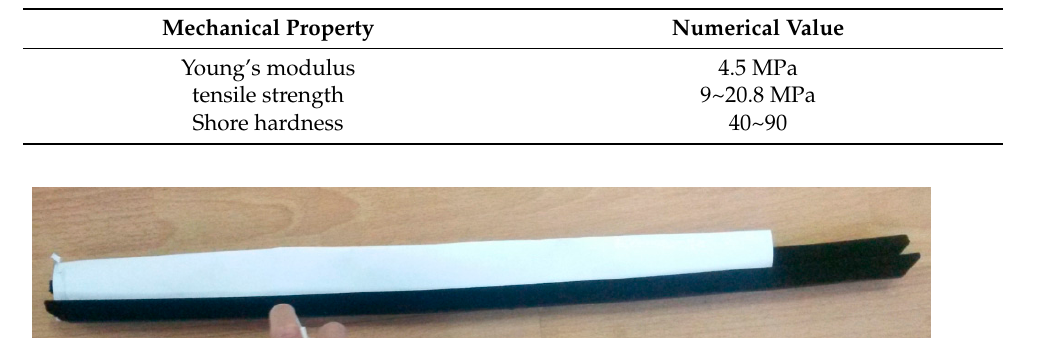
Figure 3. Inner belt. The inner belt was removed from a window with S&R.